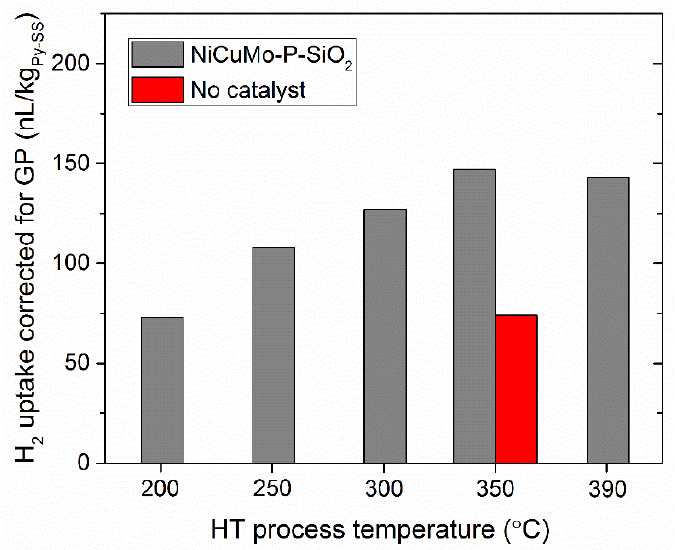
Figure 1. H 2 uptake (in normal liters per kg of Py-SS) corrected for gaseous products of pyrolysis oil hydrotreatment at temperatures in the range of 200 to 390 °C.